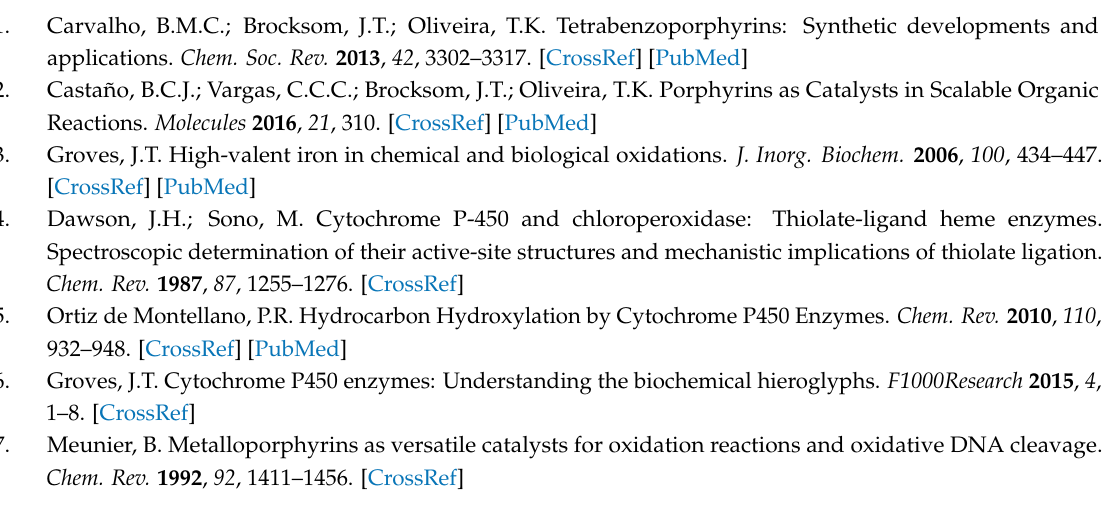
Table S1: TOF values in function of a catalyst load in the benzaldehyde acetalization reaction catalyzed by Fe5F. Figure S1: Kinetic behavior for synthesis of 2a in the presence of TEOF, catalyzed by Fe5F at different temperatures: (a) conversion values in function of time and (b) data linearization according to exponential first-order adjustment. Figure S2: Kinetic behavior for benzaldehyde cyclic acetals synthesis catalyzed by Fe5F : (a) conversion to 2d in function of time and (b) linearized data; (c) conversion to 2e in function of time and (d) linearized